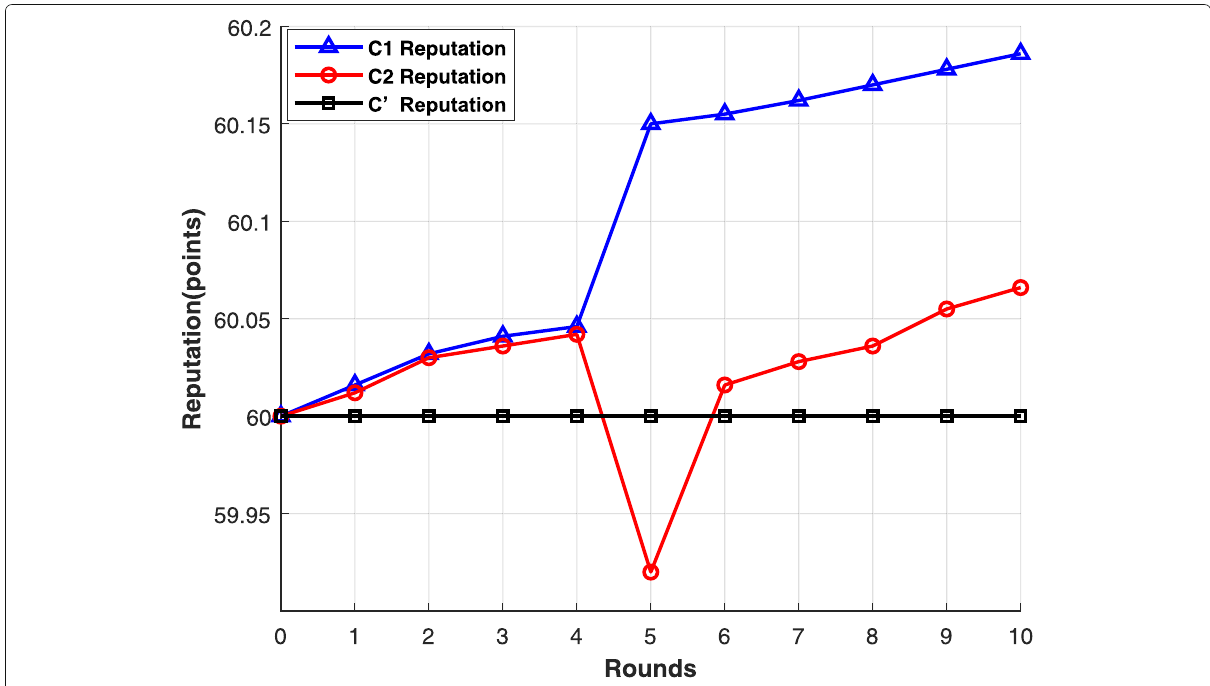
Fig. 3 Computing party’s reputation changes